Question: Provide a one-line summary of what is displayed.
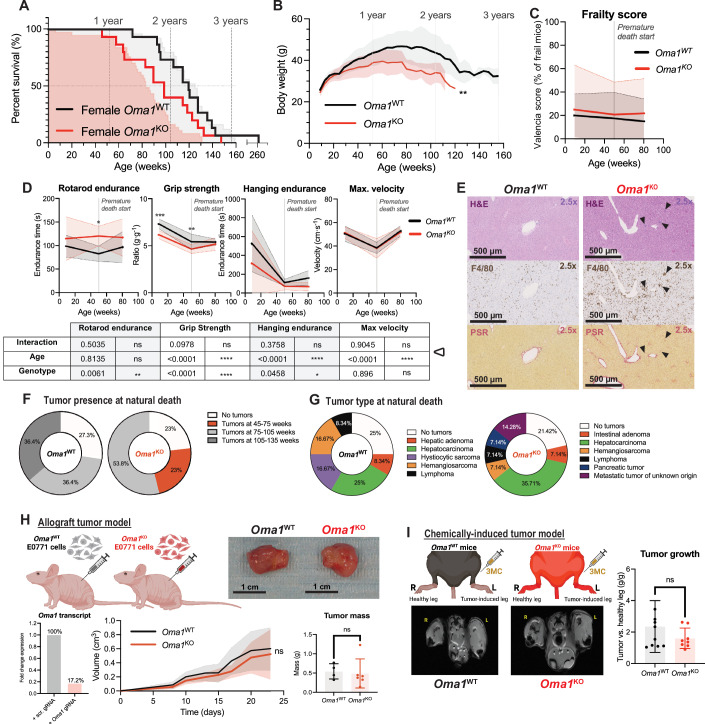
Answer: Decreased survival and increased hepatic primary tumor incidence in Oma1 KO mice. ( A ) Survival analysis of female Oma1 WT ( n = 15) and Oma1 KO ( n = 15) mice in an inbred C57BL6/JOlaHsd background. ( B ) Body weight evolution ( P = 0.0012) of male Oma1 WT ( n = 25) and Oma1 KO ( n = 37) mice in an inbred C57BL6/JOlaHsd background. This graph contains data from two separate experiments. P value from a Mixed-effects model testing the “OMA1 expression” fixed effect is represented in the graph. ( C ) Frailty score from male Oma1 WT and Oma1 KO mice at 10, 50, and 80 weeks of age, including rotarod endurance, grip strength, hanging endurance, and maximum velocity. Mice cohorts at the analyzed time points were not the same individuals. Graphical representation using continuous lines has been chosen for visual simplicity. The number of animals used at these 10, 50, and 80 weeks of age cohorts were Oma1 WT : n = 10, n = 10, and n = 5, respectively; and Oma1 KO : n = 10, n = 12, and n = 8, respectively. ( D ) Performance evolution at individual functional tests using male Oma1 WT and Oma1 KO mice at 10, 50, and 80 weeks of age, including rotarod endurance (50w P = 0.0187), grip strength (9w P = 0.0056, 50w P < 0.0001), hanging endurance, and maximum velocity. Mice cohorts at the analyzed time points were not the same individuals. Graphical representation using continuous lines has been chosen for visual simplicity. The number of animals used at these 10, 50, and 80 weeks of age cohorts were Oma1 WT : n = 10, n = 10, and n = 5, respectively; and Oma1 KO : n = 10, n = 12, and n = 8, respectively. P values from two-way ANOVA tests assessing “Age”, “Genotype”, and “Interaction” as possible sources of variation are indicated below. ( E ) Representative H&E, F4/80, and PSR histological analysis from a male Oma1 KO mouse autopsy presenting liver damage at 58 weeks of age compared to a representative 60-week-old Oma1 WT liver. Arrows indicate multifocal liver microgranuloma lesio